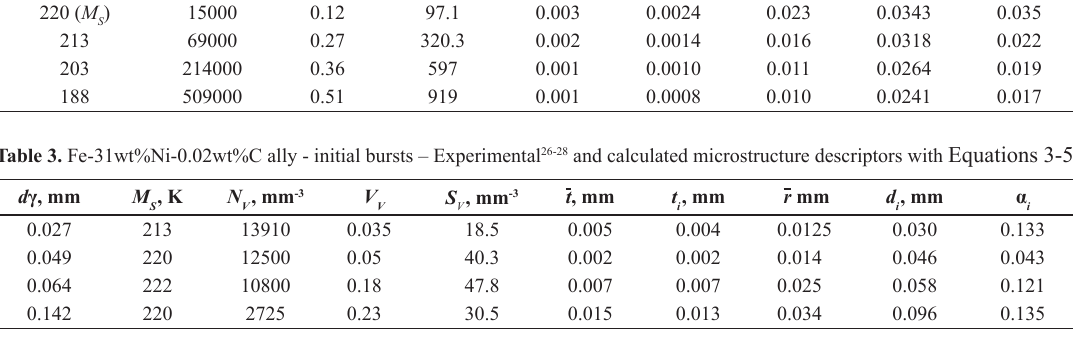
Table 2. Fe-1.86wt%C - Experimental and calculated microstructure descriptors for an austenite grain size equal to 0.110 mm 29 . Temperature, K